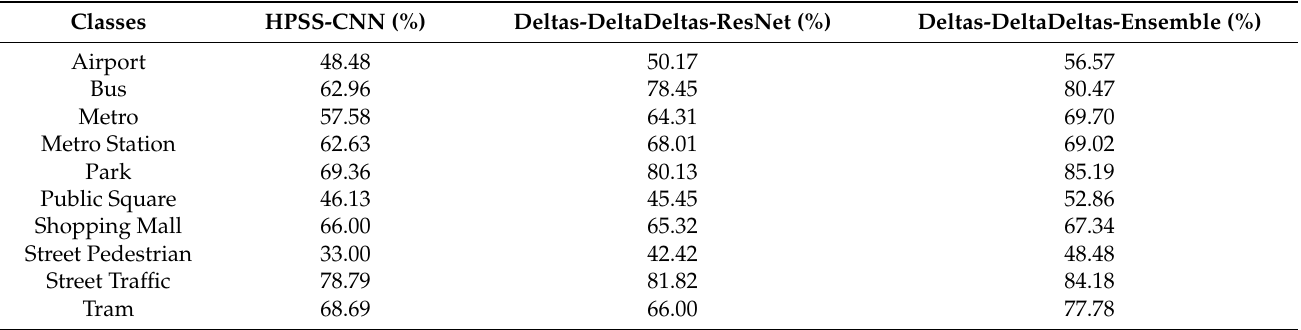
Table 2. Subtask A class-wise performance. HPSS-CNN (%), Deltas-DeltaDeltas-ResNet (%), and Deltas-DeltaDeltas- Ensemble (%) are class-wise accuracy (recall) of the development set.